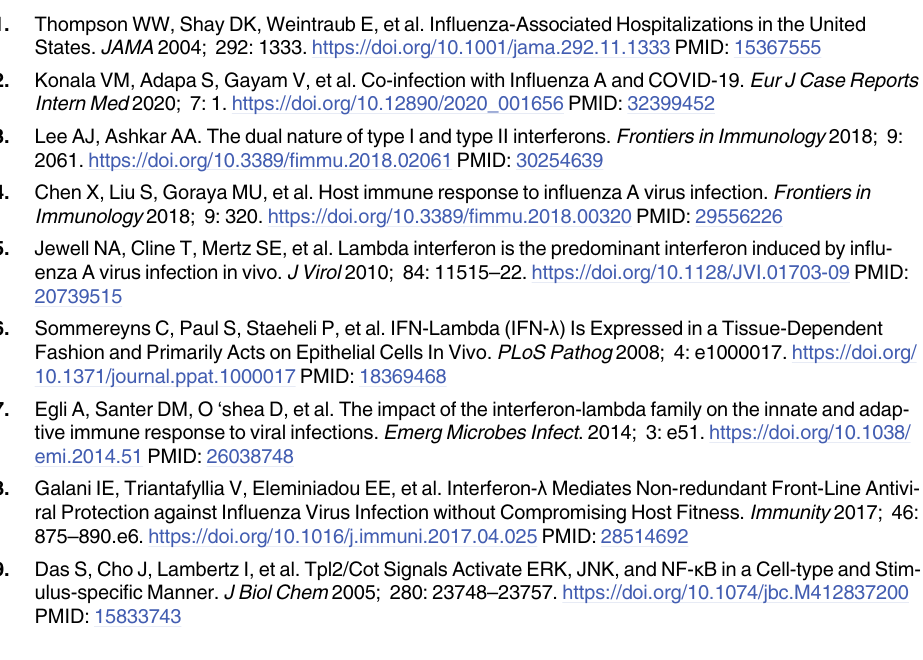
S2 Fig. Lung-specific Tpl2 ablation does not induce hematological or metabolic changes.